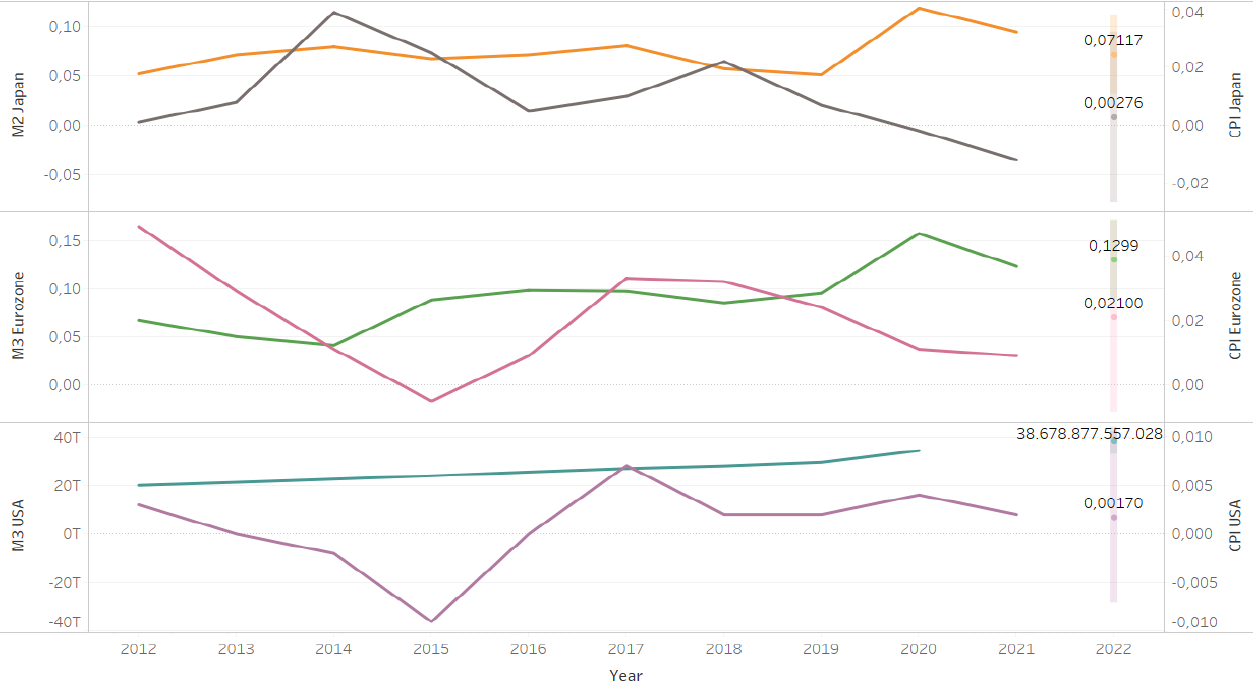
Figure 2. M2–M3 ratio with CPI and prediction. Source: prepared by the authors using Tableau Desktop professional edition and data from the International Monetary Fund, ECB, Fed, and BOJ.